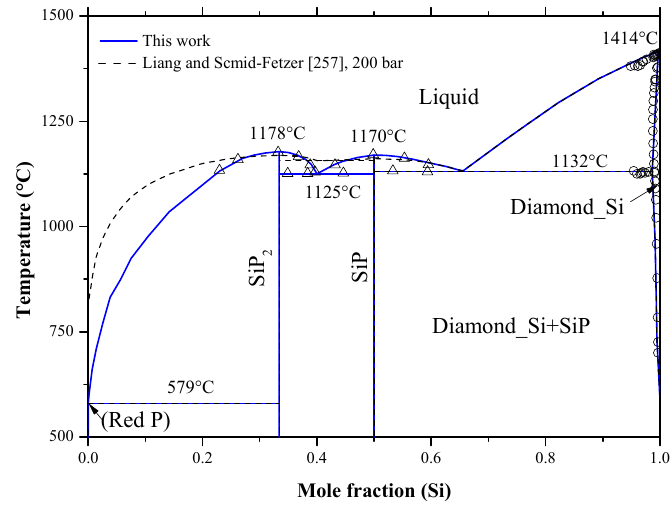
Figure 29. The P-Si phase diagram without gas phase at 200 bar; -----: [257]; Δ : [268]; ○ : [255].